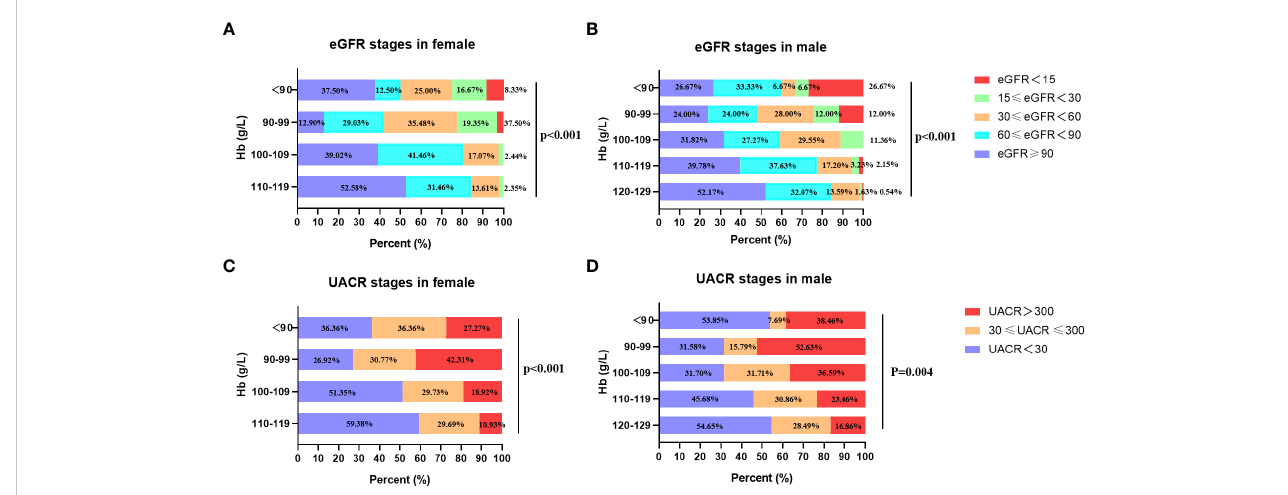
FIGURE 1 The eGFR and UACR stages in different Hb levels in females and males. (A) The relationship between eGFR stages and strati fi ed Hb concentrations in female. (B) The relationship between eGFR stages and strati fi ed Hb concentrations in male. (C) The relationship between UACR stages and strati fi ed Hb concentrations in female. (D) The relationship between UACR stages and strati fi ed Hb concentrations in